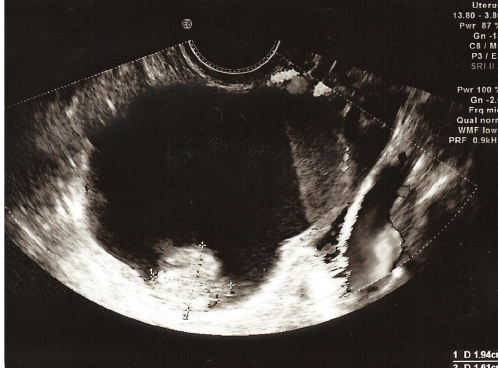
Figure 2: Pelvic ultrasound, showing the large complex ovarian cyst with layered low level echoes measuring 1.9 × 1.6